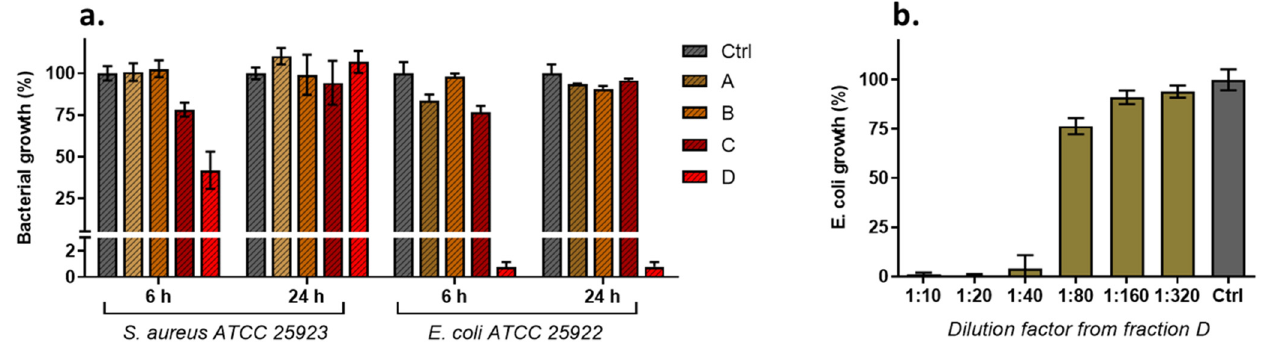
Figure 6. ( a ) Antibacterial activity of the samples (ten-fold diluted in MH broth) against S. aureus (left) and E. coli (right) reference strains after 6 and 24 h of incubation. Data are expressed as percentage values of the bacterial growth relative to the positive control. ( b ) Antibacterial activity of fraction D (serial two-fold dilutions) against E. coli reference strain following 24 h of incubation.